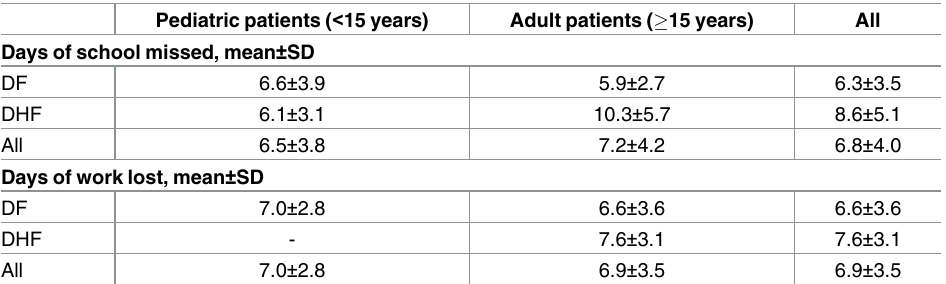
Table 4. Impact of a hospitalized dengue case on patients’ school attendance and productive activi- ties, Chacheongsao province, Thailand,